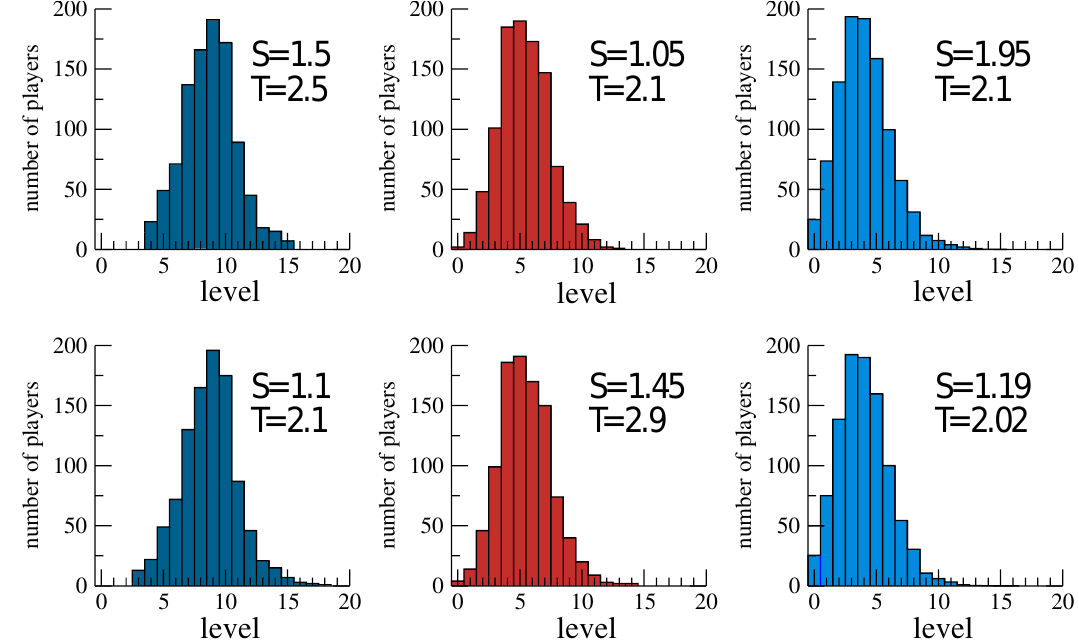
Figure 4. Histograms of the cognitive levels of the population in the stationary state of the dynamics of the SG game in Scenario B. Panels in the same vertical correspond to games in the same equivalence class m . The values of the game parameters T and S are shown inside the corresponding